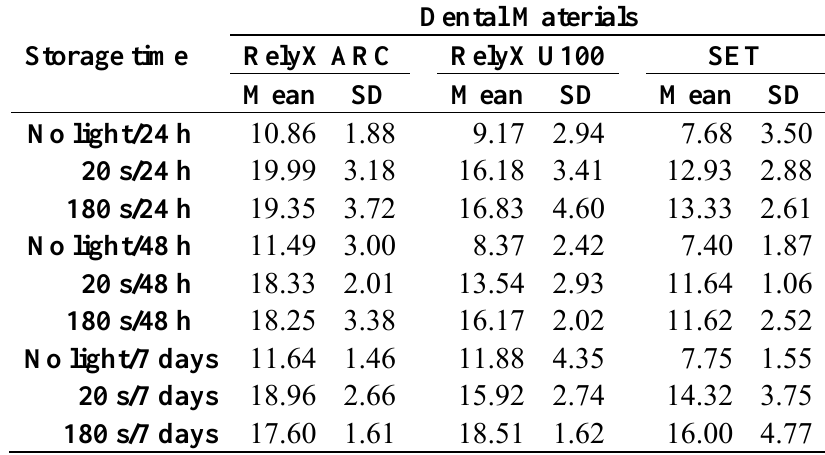
Table 1. The mean values (Kgf/mm 2 ) and standard deviation (SD) of all groups in this study. Storage